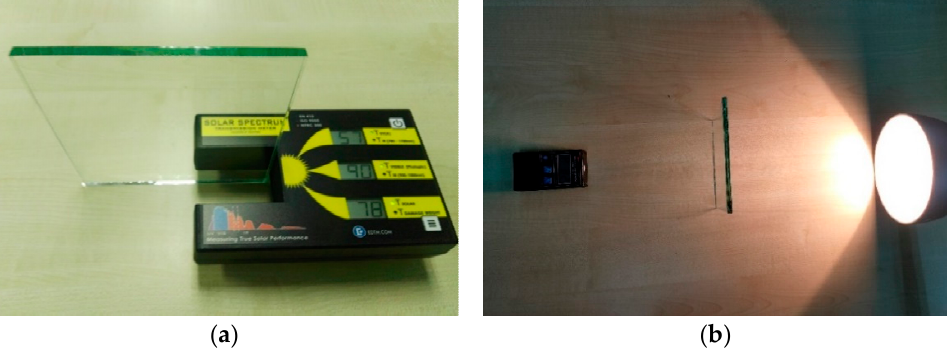
Figure 3. ( a ) EDTM-SS2450 instrument to measure the solar spectrum; ( b ) EDTM-SP2065 instrument to measure transmission power.